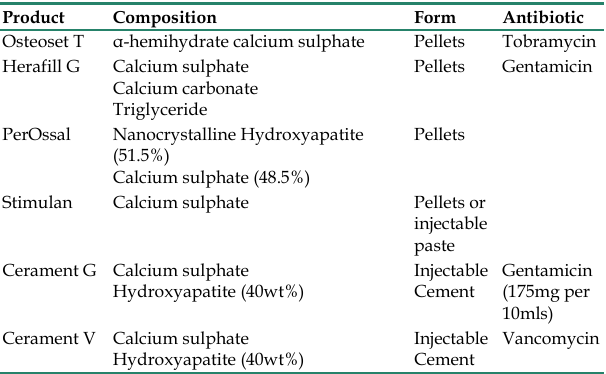
Table 4. Commercially available ceramic antibiotic